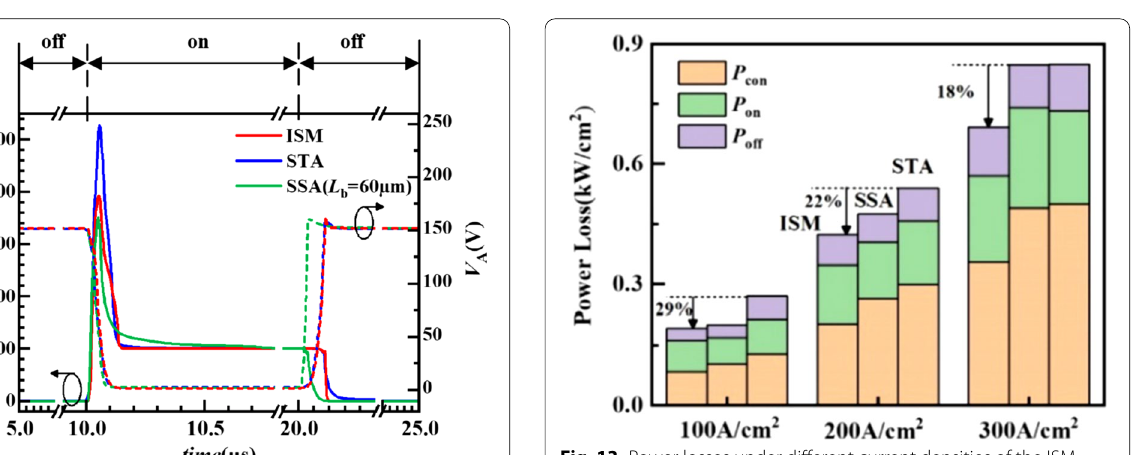
Fig. 13 Power losses under different current densities of the ISM RC-LIGBT, STA and SSA LIGBT at f s 50 kHz within 1 =